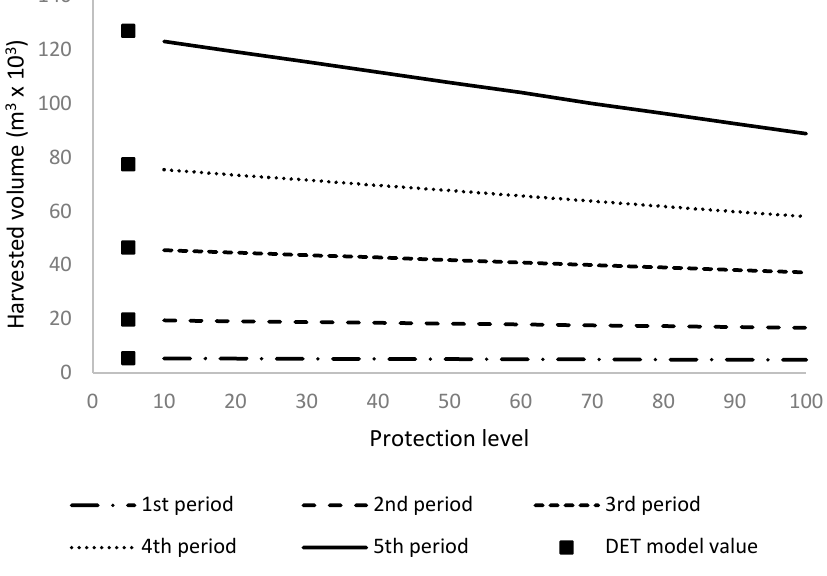
Figure 1. The relation between the protection level and the harvested volume obtained by the deterministic (DET) model and simulation experiments for each period.